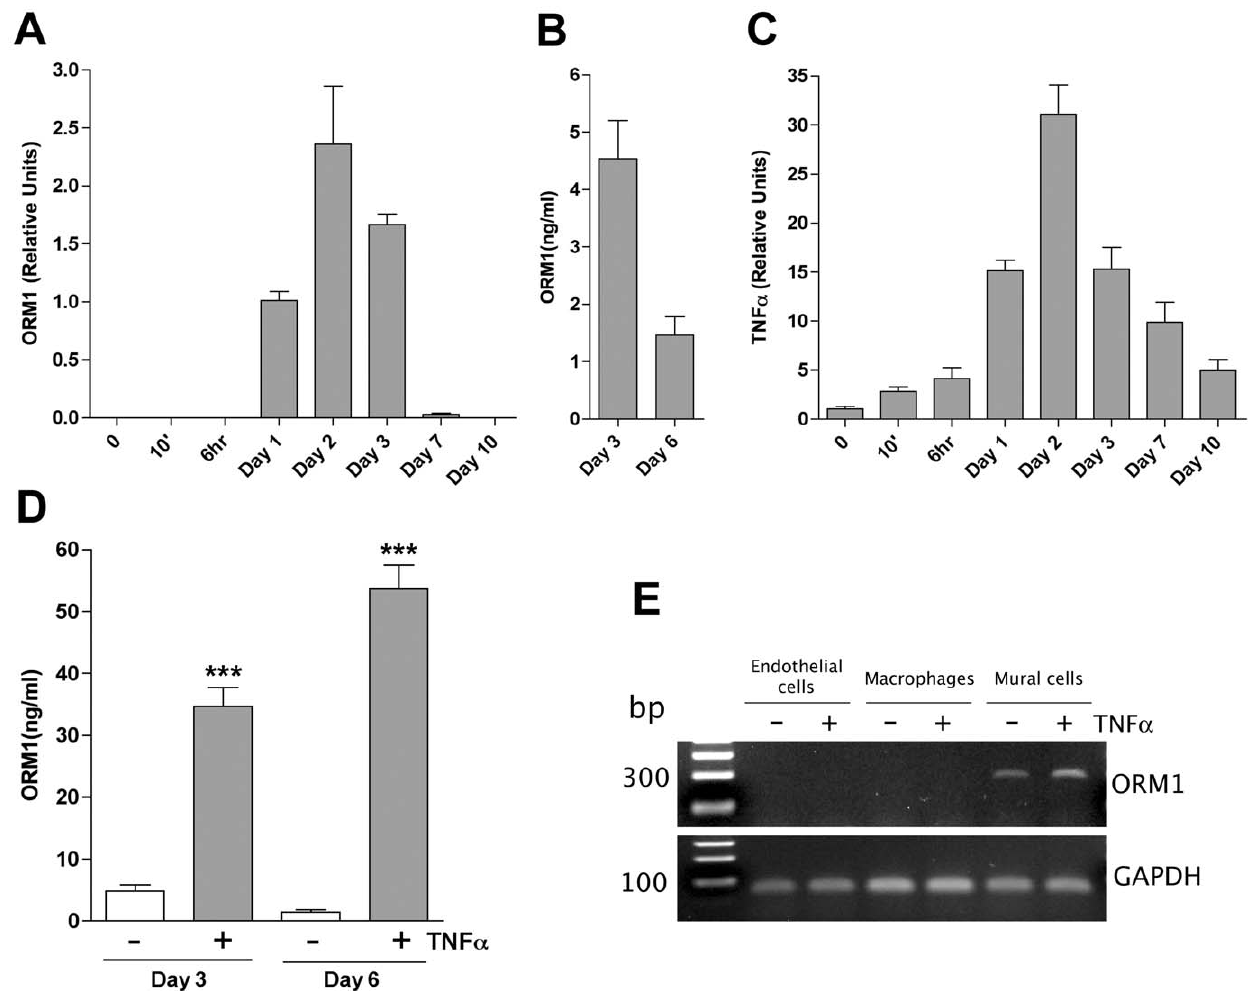
Figure 1. Expression of ORM1 in aortic ring cultures and isolated cells. (A). qRT-PCR shows that ORM1 is transiently expressed in aortic cultures during the early stages of angiogenesis (days 1–3). (B) ELISA of aortic culture conditioned media demonstrates highest production of ORM1 during the early stages of angiogenesis (day 1–3) compared to later stages (day 3–6). (C) TNF a is overexpressed rapidly (10 min) and before ORM1, peaks at day 2, and can be detected throughout the angiogenic response. (D). ELISA demonstrates marked stimulation of ORM1 production by TNF a during early and late stages of the angiogenic response (N=3; ***=p , 0.001). (E). PCR studies show that ORM1 is expressed in aortic mural cells but not in aortic endothelial cells or macrophages; ORM1 expression by mural cells is enhanced by TNF a